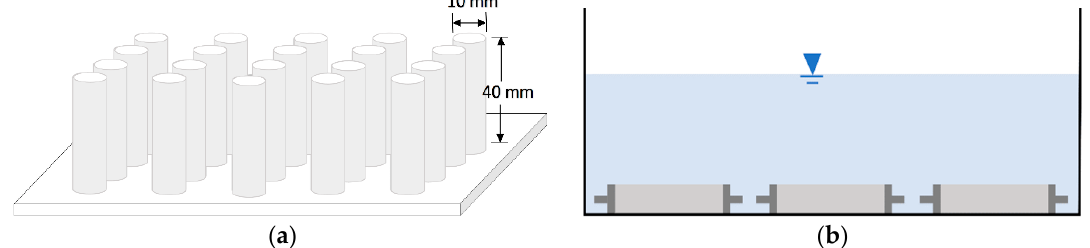
Figure 1. ( a ) A schematic diagram of molds prepared in the laboratory for casting cylindrical mortar specimens; ( b ) Mortar specimens immersed in Na 2 SO 4